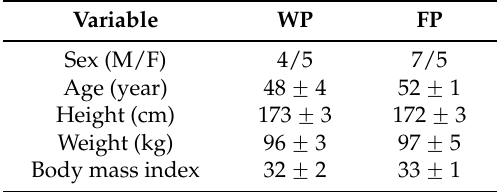
Table 1. Participant Characteristics.